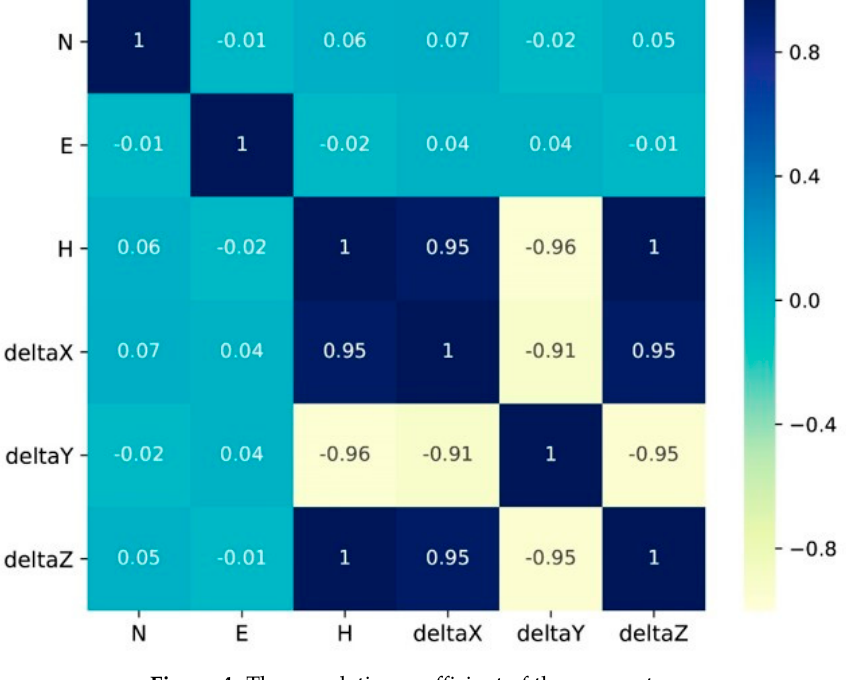
Figure 4. The correlation coefficient of the parameters.